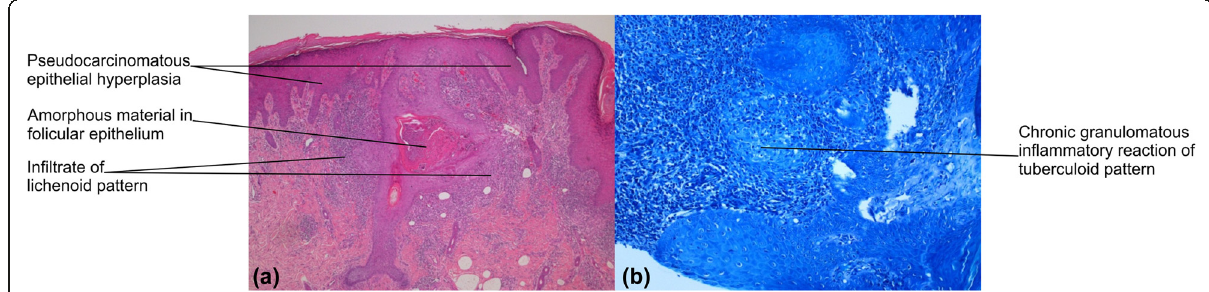
Figure 2 Skin biopsy - Histopathology. (a) Pseudocarcinomatous epithelial hyperplasia with amorphous material in the follicular epithelium, which is surrounded by intense infiltrates of lichenoid pattern (HE, original magnification 40×). (b) Chronic granulomatous inflammatory reaction of tuberculoid pattern with focus of fibrinoid necrosis and absence of acid-fast bacilli (Fite-Faraco, original magnification 200×).